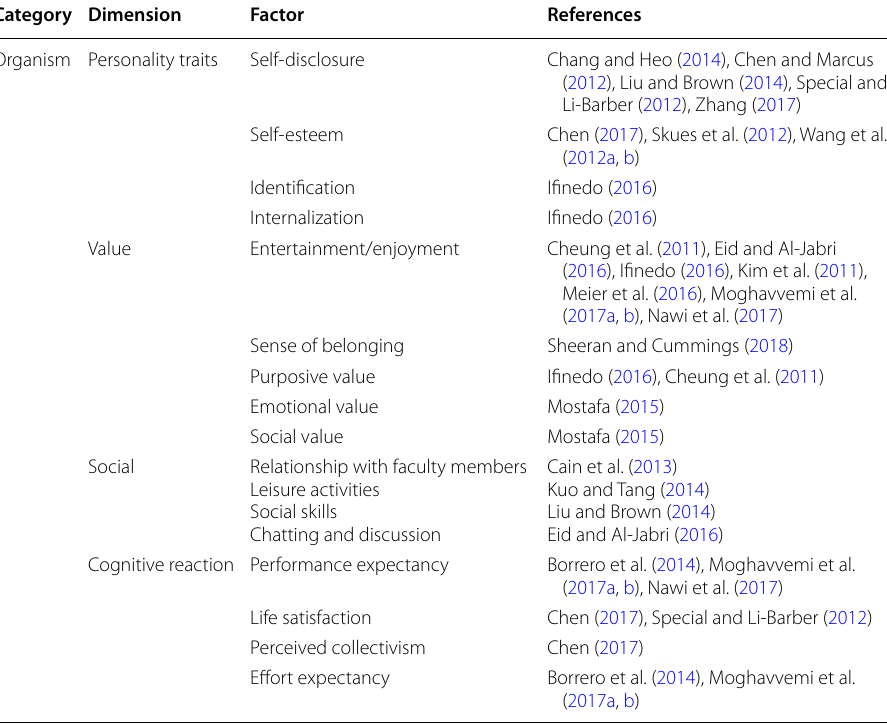
Table 5 Factors classified under organism Category